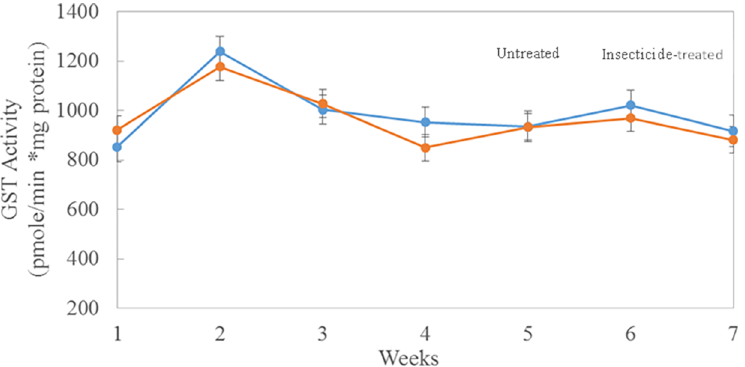
Fig 6. GST activity from bees collected weekly from five insecticide-treated (orange line) or–untreated (blue line) sites. Points represent mean activities (pmole/min (cid:3) mg protein; ± SEM) from triplicate assays of 10 bees collected from 3 colonies from each treated or control